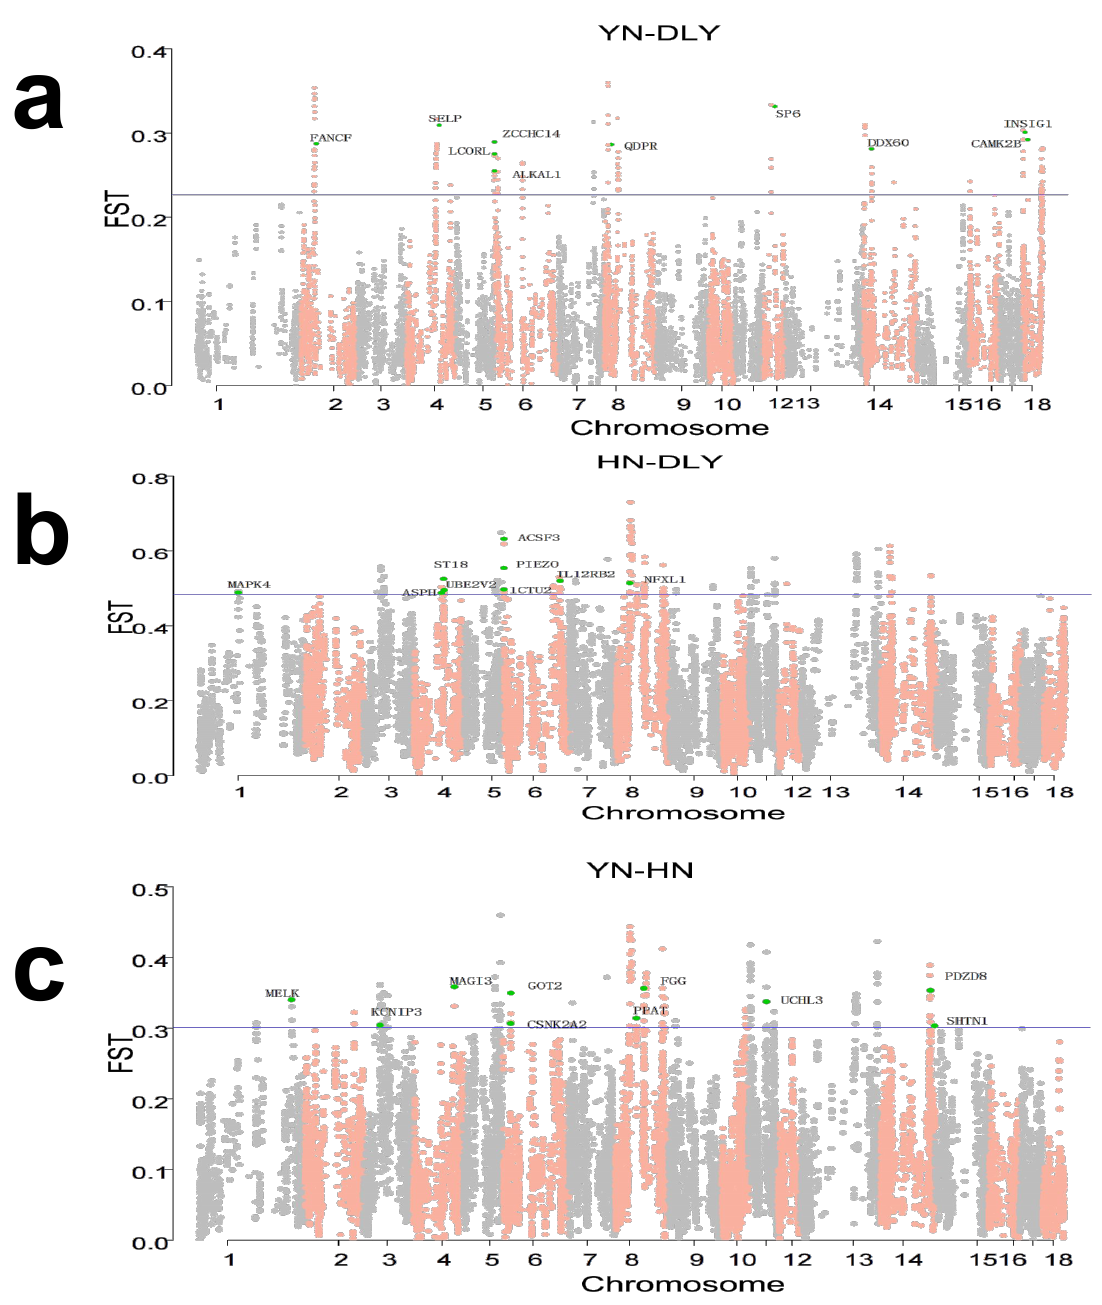
Figure 3. Genome-wide distribution of selection signatures detected by Fst. ( a ) Fst statistics across all autosomes in YN black pigs. ( b ) Fst statistics across all autosomes in HN pigs. ( c ) Fst statistics across all autosomes in DLY pigs. The blue line corresponds to the 99% threshold on the corresponding empirical